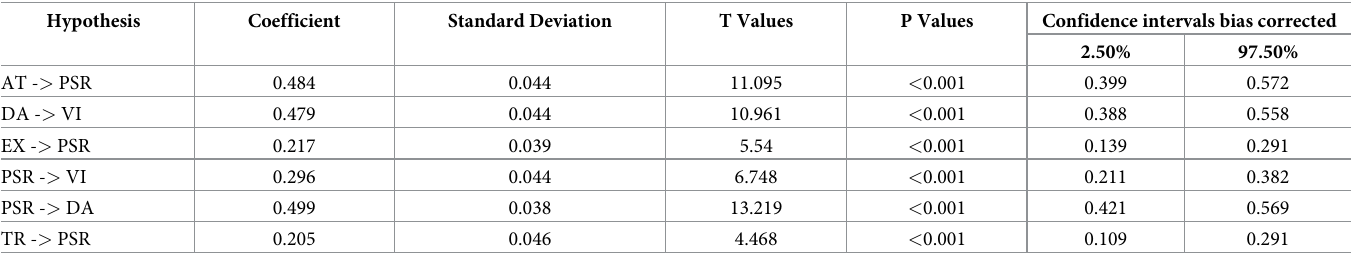
Table 4. Direct path for the structual